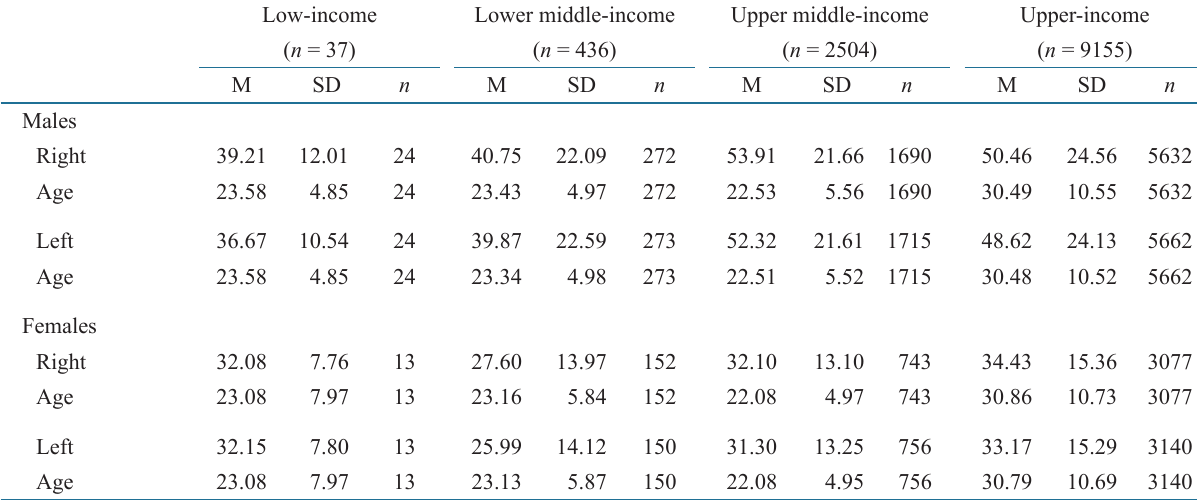
Note. M = mean; SD = standard deviation.